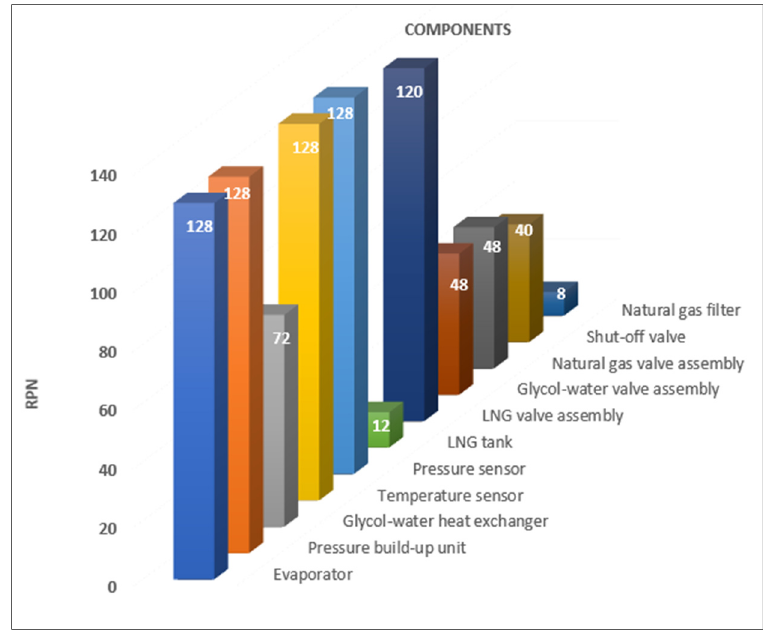
Figure 7. LNG fuel system component RPN values.